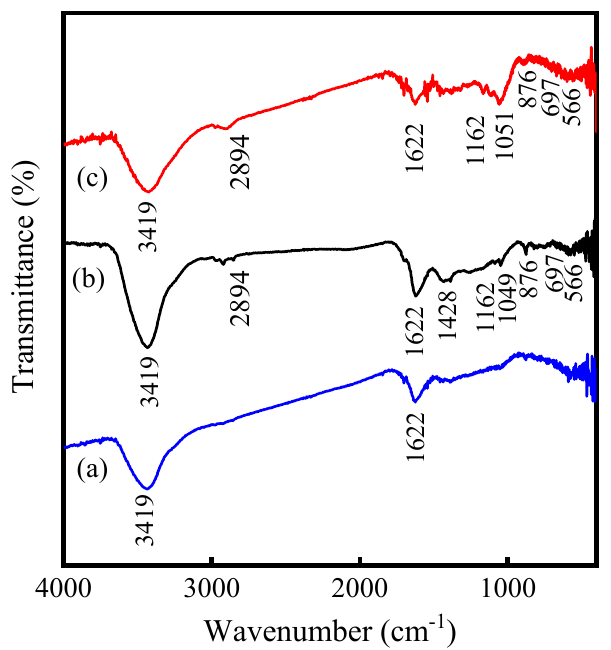
Figure 8. FTIR spectrum of MBC and FM-MBC. ( a ) MBC, ( b ) FM-MBC, ( c ) FM-MBC after Cr(VI) adsorption.